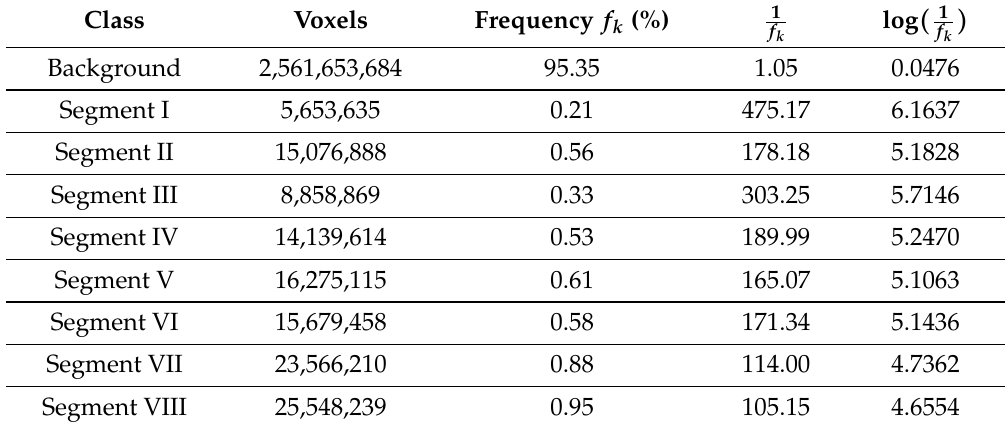
Table 1. Class distribution for the selected training set (n=168) from MSD 08 dataset.